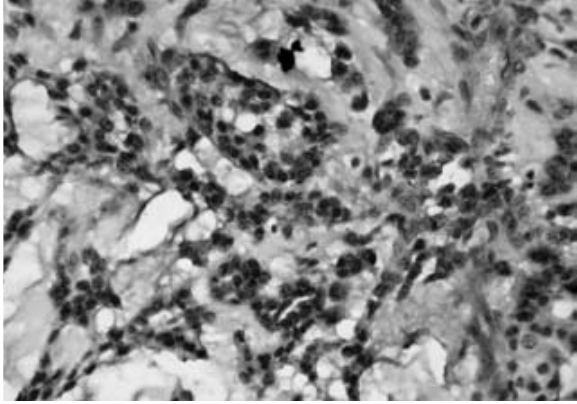
Figura 3 – Imunomarcação para p53 em células poligonais